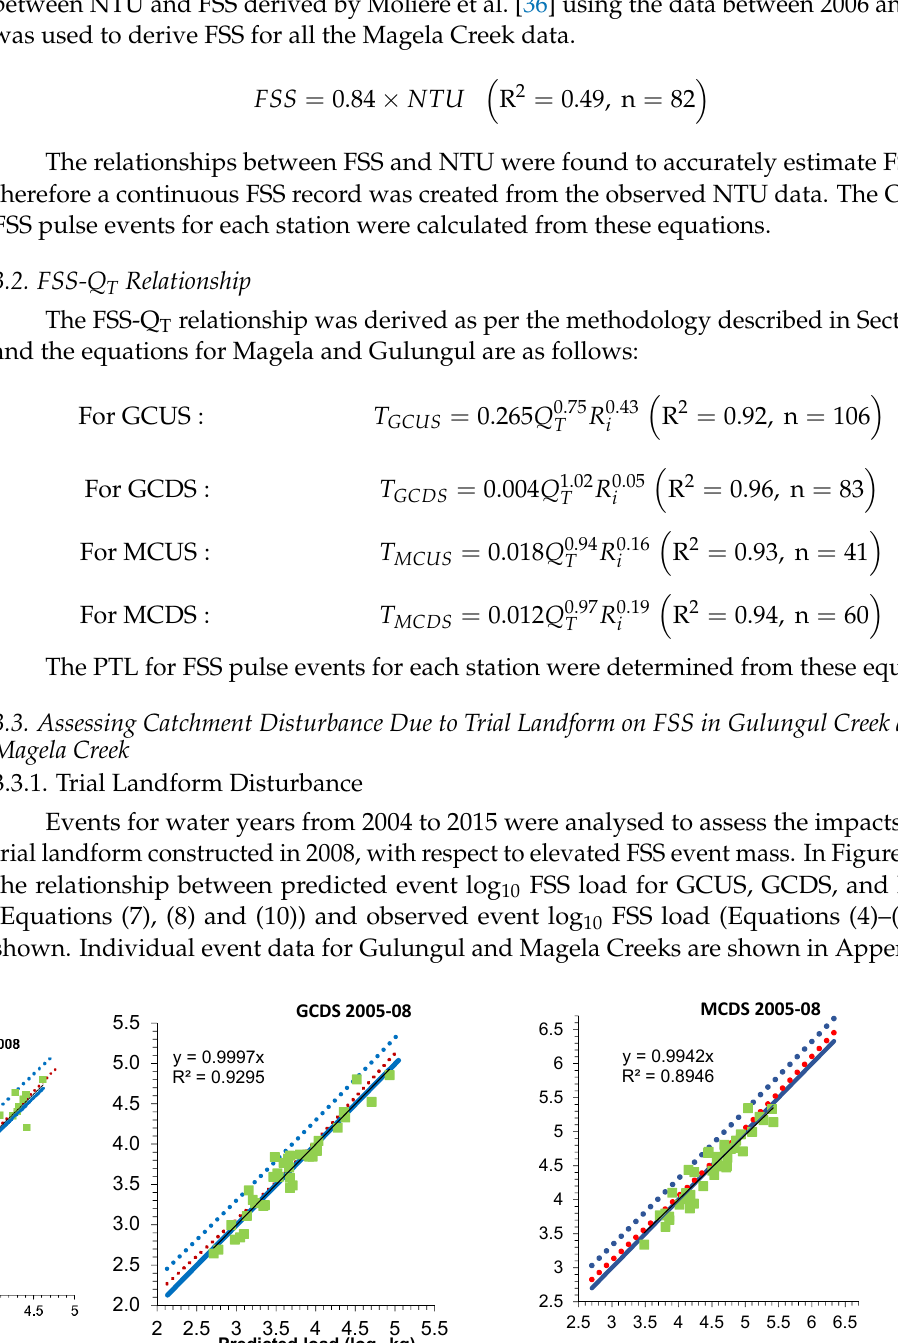
Figure 7. Relationship between OTL and PTL at GCUS ( a ), GCDS ( b ), and MCDS ( c ) (2003–2008). The dark blue line in each graph is the best fit (1:1) line for the undisturbed relationship data. The red dashed line is the 95% confidence limit and the blue dashed line is the 95% prediction limit of the 1:1 line. The black line is the fitted line for the events in each year. Each event is shown as marker point in the graph. The markers are colored green when the events are evenly distributed around the best fit line (no disturbance in the catchment) and red otherwise.